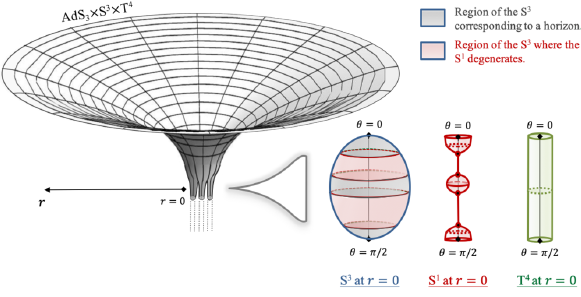
Figure 16 . Schematic description of the spacetime induced by a chain of 5 rods, inducing either horizons or the degeneracy of the S 1 ( y ). On the left-hand side, we depict the overall geometry in terms of r . On the right-hand side, we describe the behavior of the S 3 , S 1 , and T 4 at r = 0 depending on the position on the S 3 given by θ